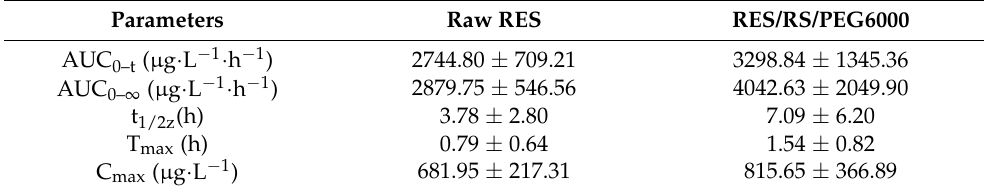
Figure 15. Plasma concentration-time profiles of RES and RES/RS/PEG6000 after drug administra- tion in rats. Table 11. Pharmacokinetic parameters of raw RES and SRSDs in rats after oral administration ( n =